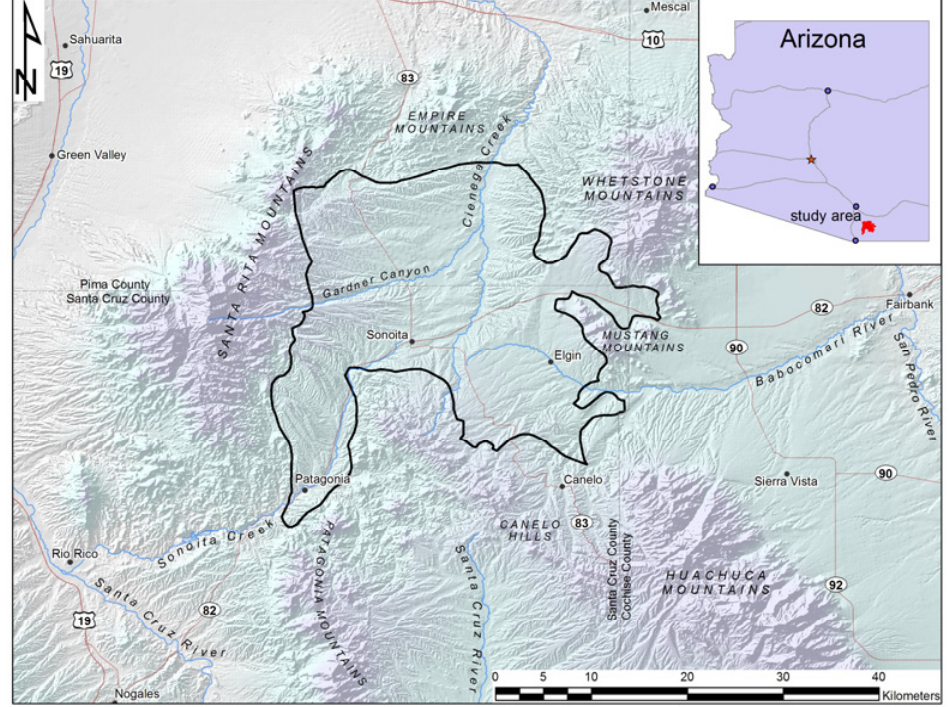
Figure 1. Map of the Sonoita Plain, highlighting the mountains surrounding the study